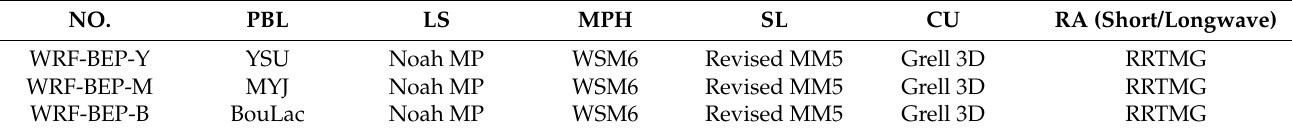
Table 1. Physical Scheme Combinations Used for WRF-BEP Simulations.